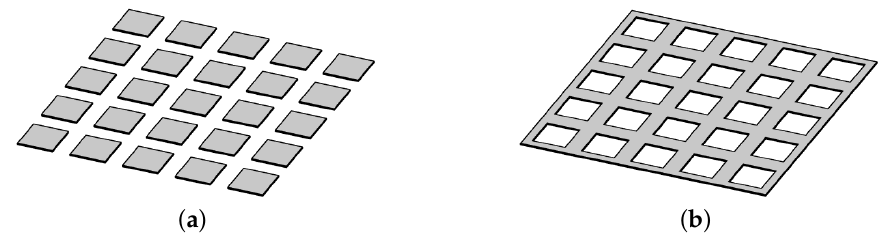
Figure 5. Electromagnetic surfaces consisting of ( a ) isolated scatterers ( b ) isolated apertures.